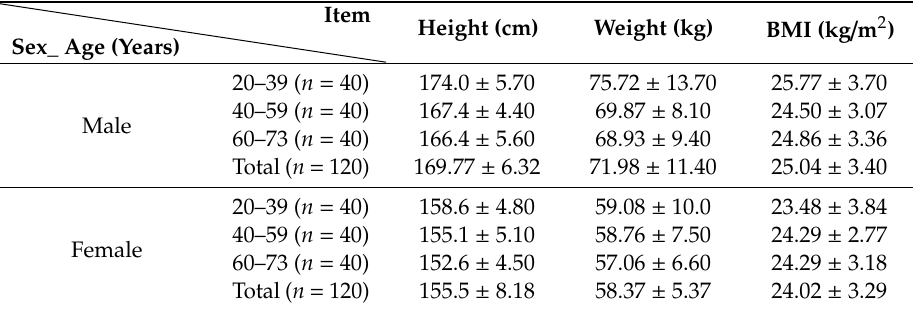
Table 1. Physical characteristics of participants according to age and